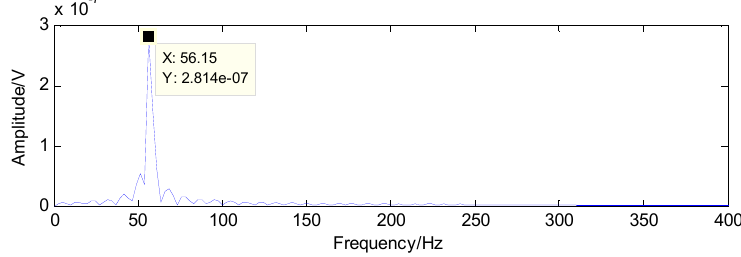
Figure 16. The detected fault characteristic frequency through matching pursuit. Sensors 2016 , 16 , 1524